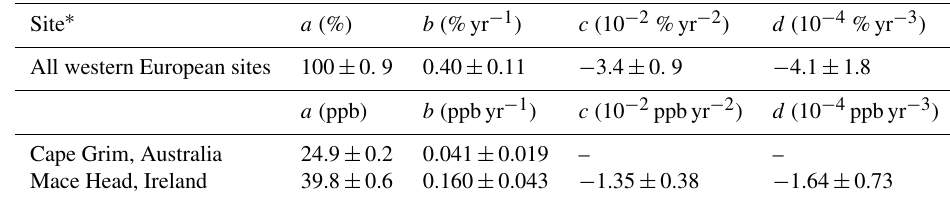
Table 2. Coefficients of polynomials ( a + bt + ct 2 + dt 3 , where t = year − 2000) that define the long-term ozone changes given by the cubic polynomial fit in Fig. 2a and the solid curves in Figs. 3 and 4.